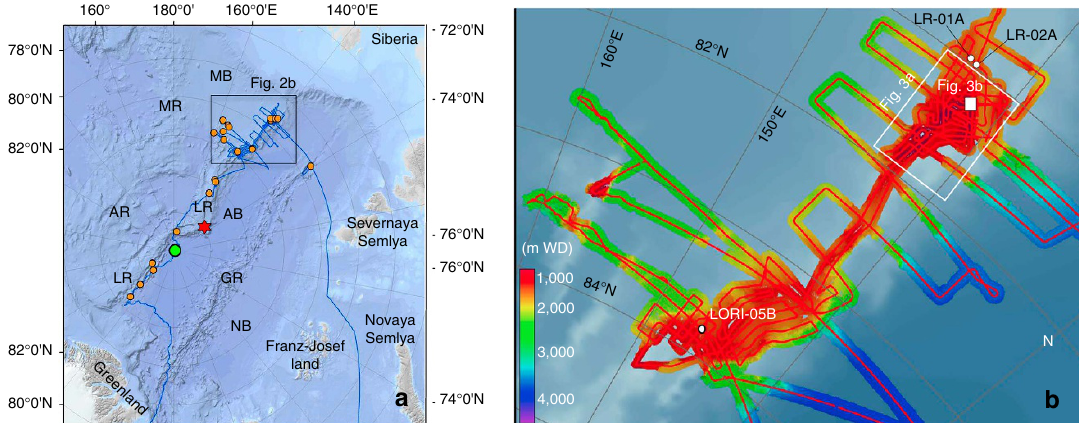
Figure 2 | Cruise track and multibeam bathymetric survey of Polarstern Expedition PS87. ( a ) PS87 cruise track (blue line) 17 . AB, Amundsen Basin; AR, Alpha Ridge; GR, Gakkel Ridge; LR, Lomonosov Ridge; MB, Makarov Basin; MR, Mendeleev Ridge; NB, Nansen Basin. Orange circles indicate coring stations, the red asterisk indicates the location of the ACEX Site and the green circle indicates the North Pole ( Polarstern reached on 26 August 2014 at 10:23 UTC). ( b ) Track lines of multibeam bathymetric survey. Colour bar indicates water depth in metres (m WD). LR-01A, LR-02A and LORI-05B indicate locations of proposed IODP drill sites 51 ( cf ., IODP Proposal 708; http://www.iodp.org/expeditions). Areas of Fig. 3a,b are indicated.